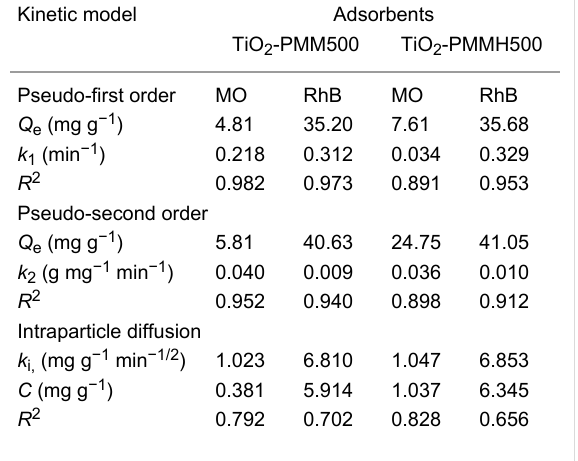
Table 6: Parameters of methyl orange (MO) and rhodamine B (RhB) dye adsorption kinetics for the obtained TiO 2 -pillared MM